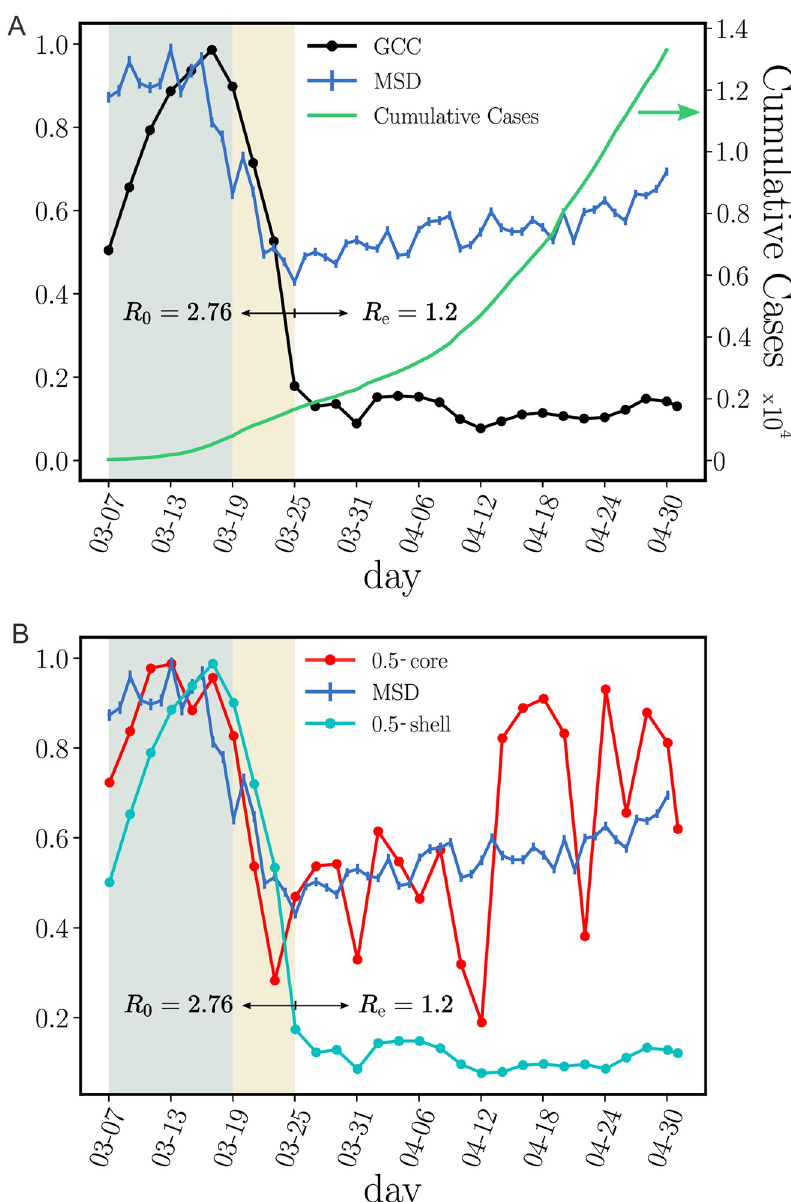
Fig 3. Structural components of transmission networks across the lockdown. (A) Evolution for different metrics in Ceara´, Brazil, previous to the mass quarantine (grey area), right after the imposed quarantine (yellow area) and later. The plot shows the root mean square displacement (MSD) normalized by the maximum value over the total period (blue), the cumulative number of cases (green) and the size of the GCC normalized by the maximum value over the total period (black). The uncertainty corresponds to the standard error (SE). The mobility data is showcased in the Grandata-United Nations Development Programme map shown in https://covid.grandata.com. The initial rise in GCC is due to the lack of data before March 1. (B) The plot shows the 0.5-core size (red), the 0.5-shell size (cyan) all normalized by their respective maximum value pre-lockdown. While the size of the 0.5-shell is reduced drastically during the lockdown, the 0.5-core was not reduced as much and keeps increasing, contributing to sustain the pandemic. The 0.5-core seems to follow the trend in the MSD, which we plot again to show this trend.